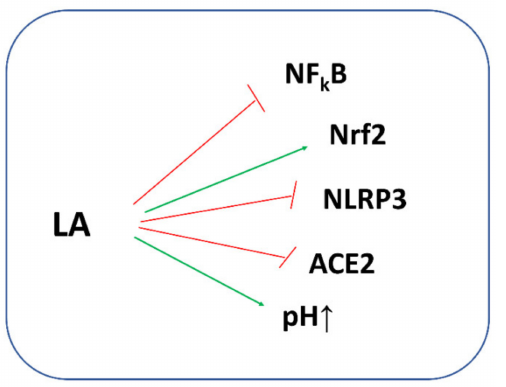
Figure 9. Biological potential of LA in the fight against COVID-19. LA exerts anti-inflammatory action via inhibiting the activity of NF k B and NLRP3 inflammasomes and activating the nuclear erythroid 2-related factor 2 (Nrf2). LA decreases the risk of SARS-CoV-2 entry into the cell by increasing the intracellular pH. Moreover, LA may decrease the activity of the angiotensin-converting enzyme 2 (ACE2)